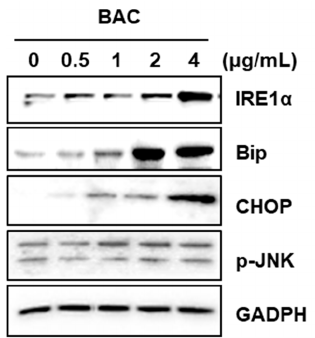
Figure 4. ER stress promoted by BAC in H358 cells. Western blot analysis of ER stress-related proteins was performed after BAC treatment for 24 h. GAPDH is used as a loading control.